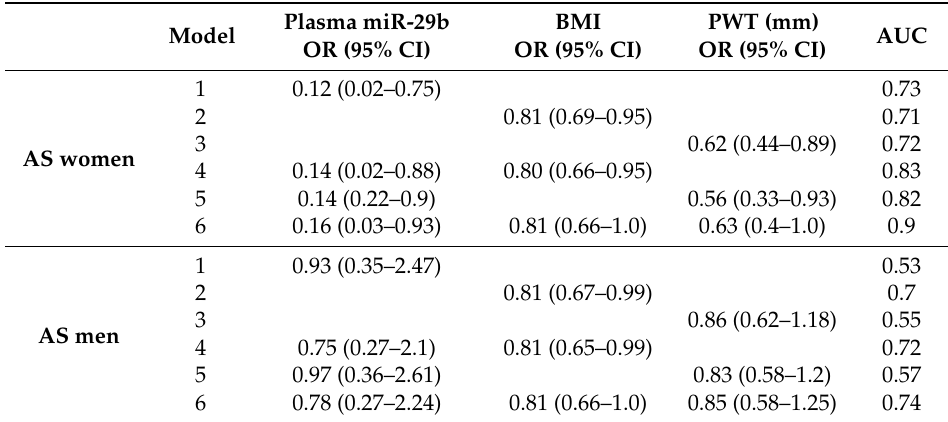
Figure 8. Linear regression and Pearson’s correlation analyses showing the relationship between plasma miR-29b expression and morpho-functional parameters in patients older than 50 years. IVST, interventricular septum thickness in men ( A ) and women ( B ); rPWT, relative posterior wall thickness in men ( C ) and women ( D ); MAPSE, mitral annular plane systolic excursion in men ( E ) and women ( F ). r, Pearson’s correlation coe ffi cient. * p < 0.05, ** p < 0.01. $ Comparative analysis of women vs. men correlations with cocor. Table 2. Logistic regression analysis predictive models of LV mass normalization one year after aortic valve replacement in aortic stenosis (AS)